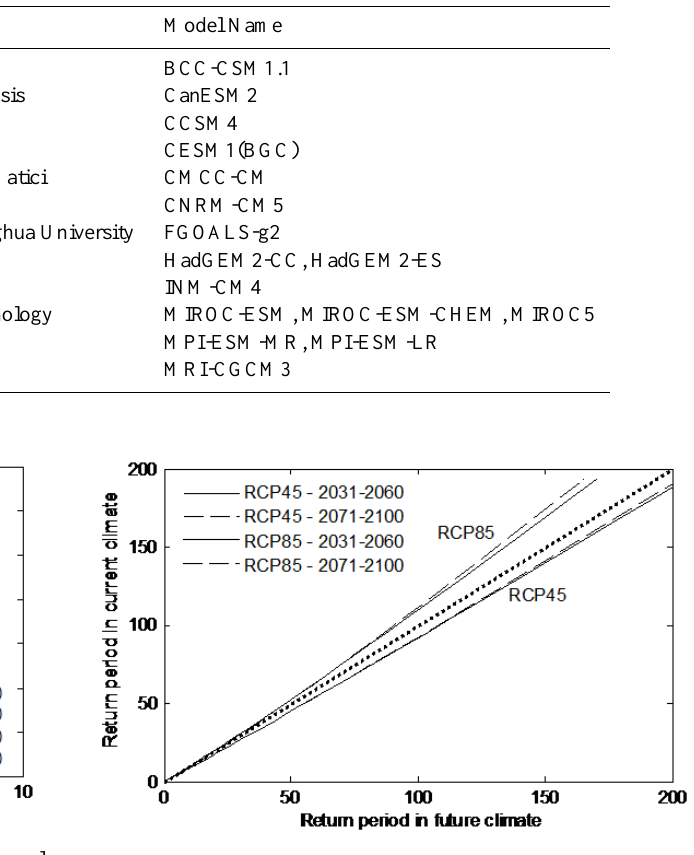
Figure 3. Changes in mean annual precipitation and mean annual temperature for the Red River basin as projected by the 16 climate models used in the study. (cid:49)P is the ratio between the future and the control climate. (cid:49)T is the difference between future and control mean temperature in degree Celsius.